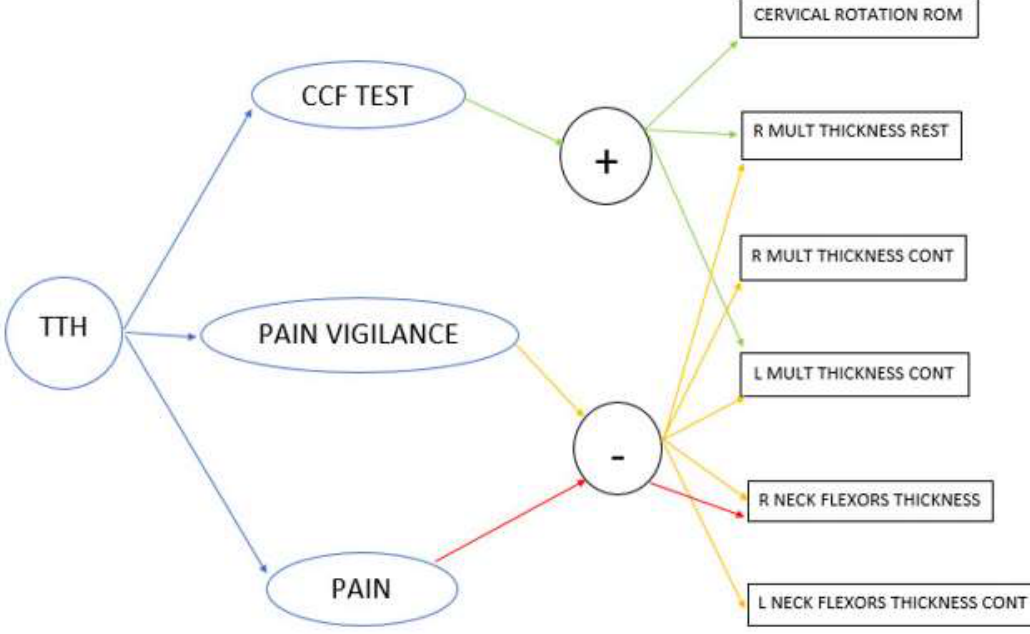
Figure 2. Correlations between the variables. Positive (+) and negative (−) correlations are shown from TTH (Tension-type headache) with craniocervical flexion (CCF) test, Pain vigilance and levels of headache. Abbreviations: R (right), L (left), Mult (Multifidus), Cont (in contraction).